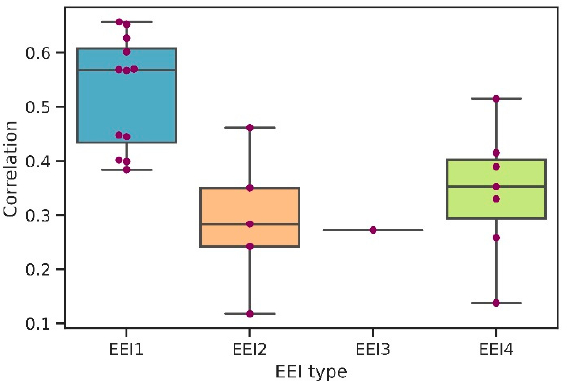
Figure 2. Spearman’s correlation coefficients between protein abundance and EEI distribution among 5 EEI types for 25 prokaryotes ( Neisseria meningitidis , the organism with p -value > 0.05, is excluded).